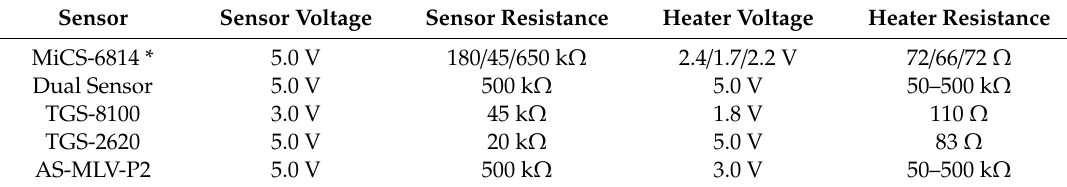
Figure 6. Simplified circuit diagram of sensor and heater drive circuits for analogue MOX sensors. Table 2. Sensor and heater voltages and resistances for analogue VOC sensors.